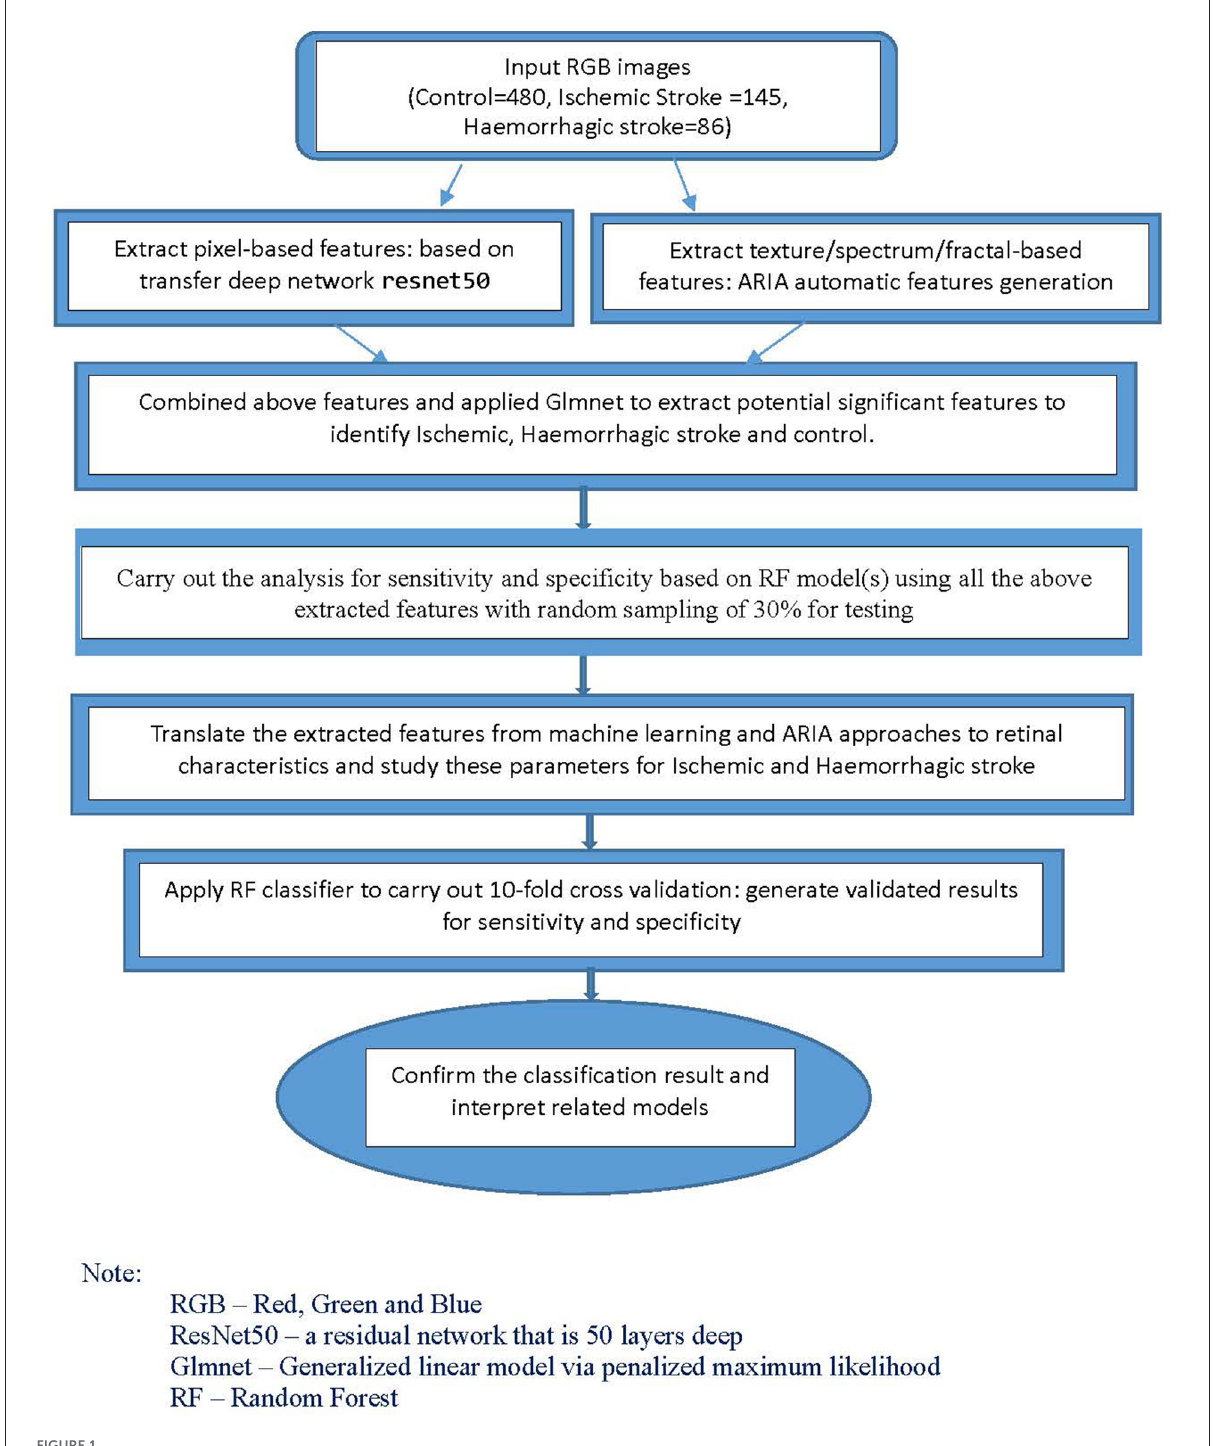
FIGURE1 Flowchart of the method for the development of the classification model.